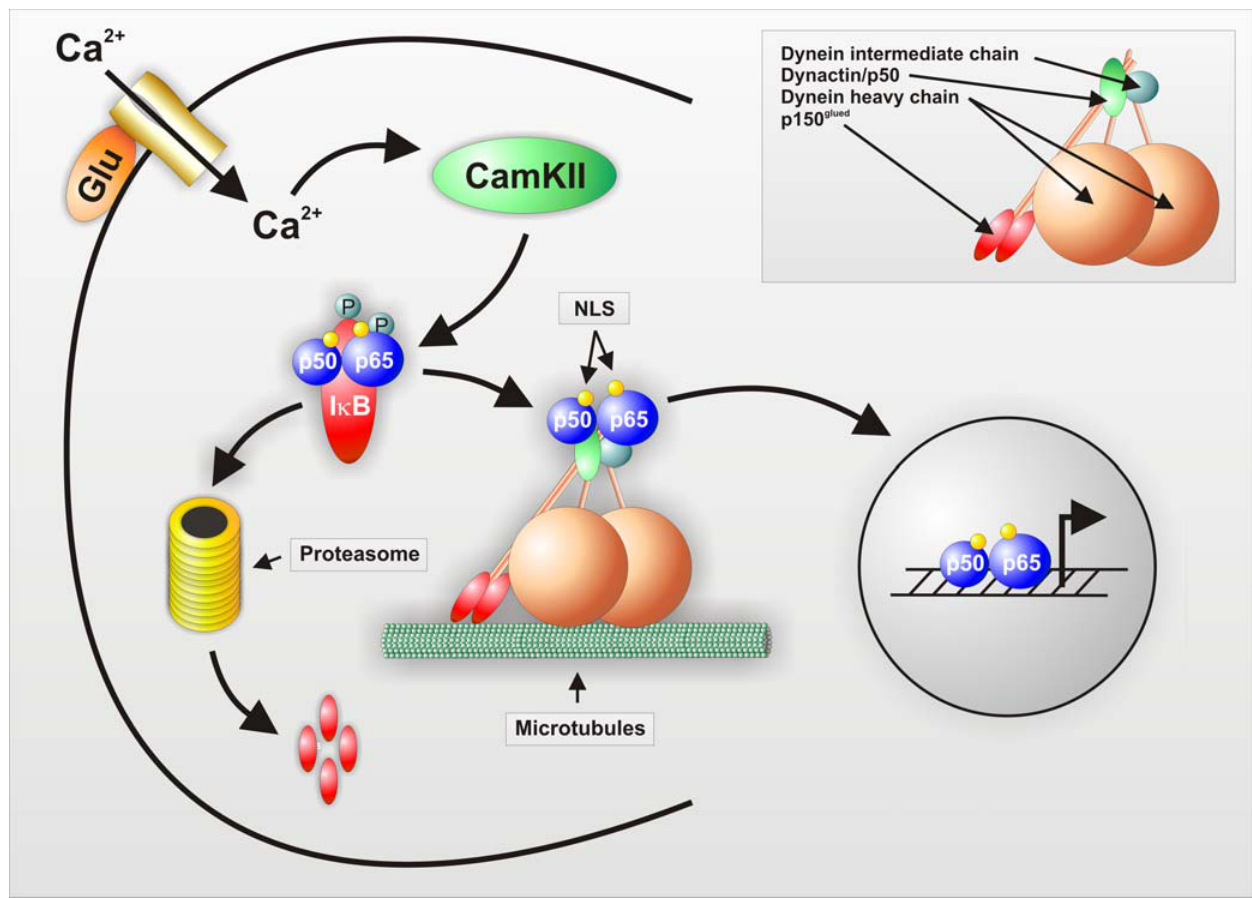
Figure 5. Schematic presentation for the NF- k B activation by synaptic activity and its dynein-mediated retrograde transport to the nucleus along microtubules. Upon stimulation of primary neurons with glutamate, different signalling pathways (represented here by CaMKII) originating from intracellular Ca 2 + elevation induces phosphorylation of I k B, which subsequently leads to its degradation within the proteasome. Thereby, the nuclear localisation signals (NLS) of NF- k B subunits are unmasked, allowing its binding to importin a / b heterodimer. This complex is then transported retrogradely towards the nucleus via an association with motor protein dynein/dynactin, where it activates NF- k B target genes.